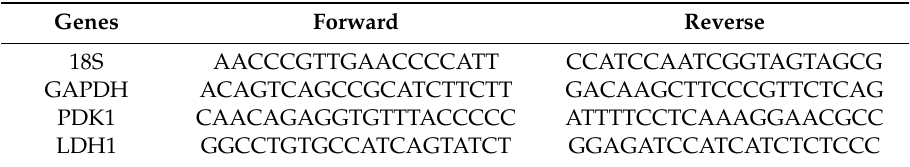
Table 1. Primers used in